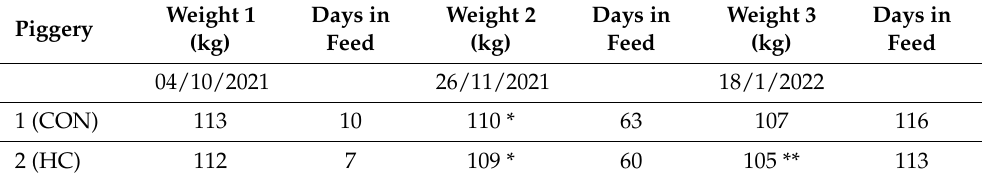
Table 3. Animals weighted at each